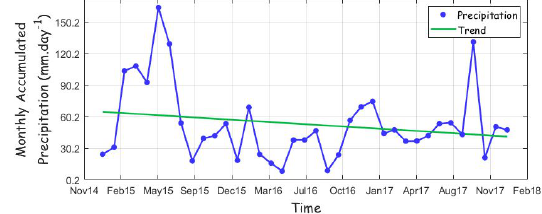
Figure 12. Monthly mean accumulated precipitation (blue line and circles) from January 2014 to November 2017 and its trend line (green).